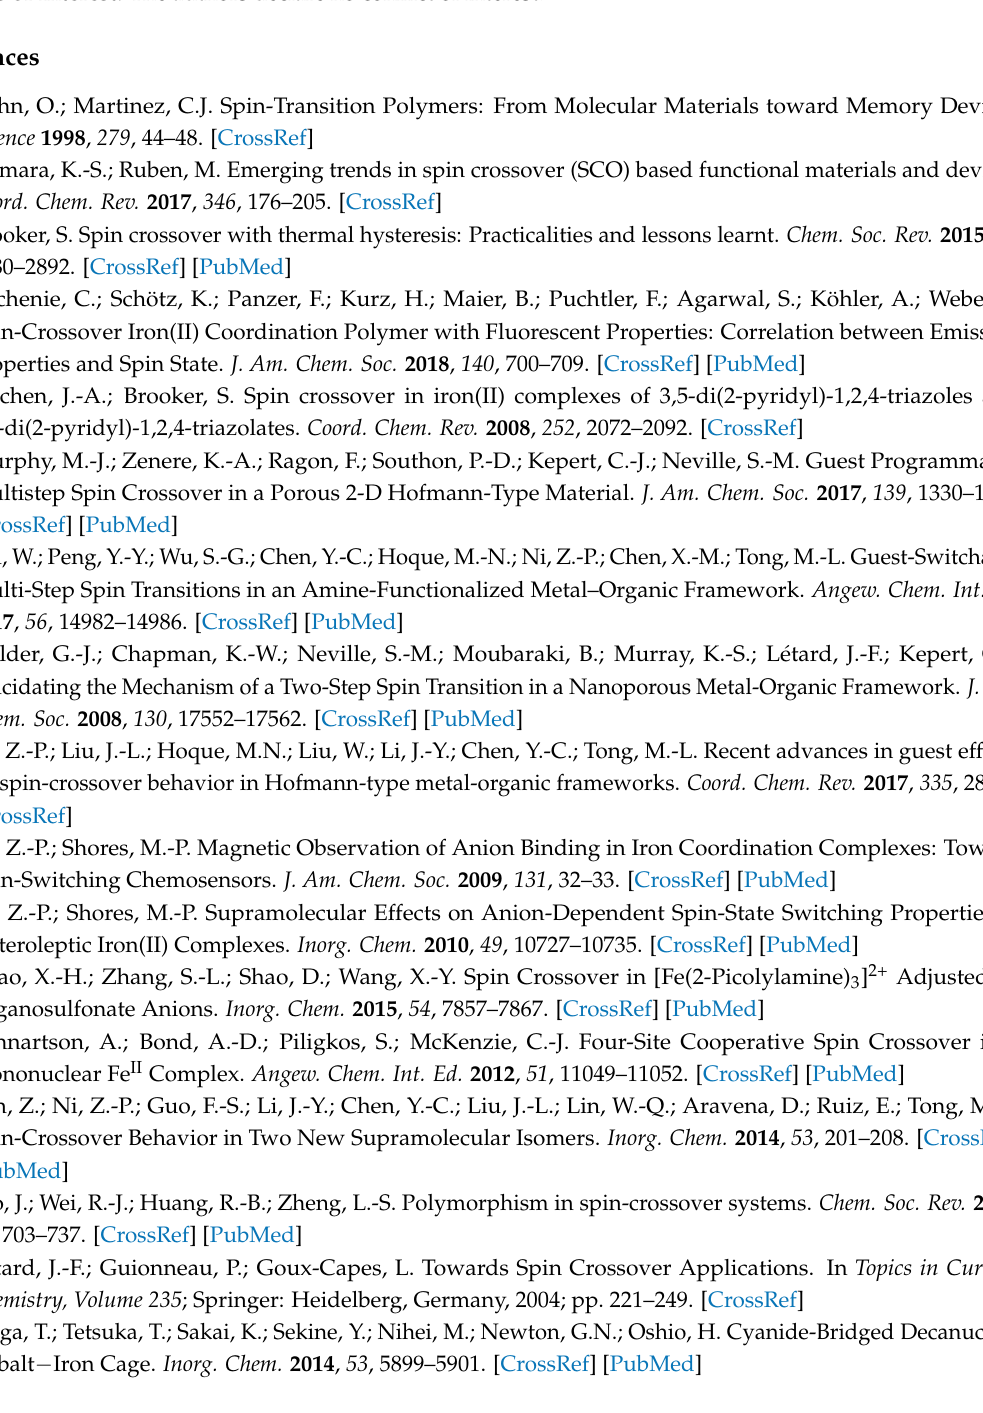
Figure S3: Packing diagram of 1 ; Figure S4. Structural illustrations of 3 : the hydrogen bond interactions. Figure S5: Plots of χ M T vs. T for 1 ; Figure S6: Plots of χ M T vs. T for 1 and Cl-analogue. Table S1: Geometrical Parameters of the Hydrogen Bonds in Compound 1 ; Table S2: Geometrical Parameters of the Hydrogen Bonds in Compound 2 ; Table S3: Geometrical Parameters of the Hydrogen Bonds in Compound 3